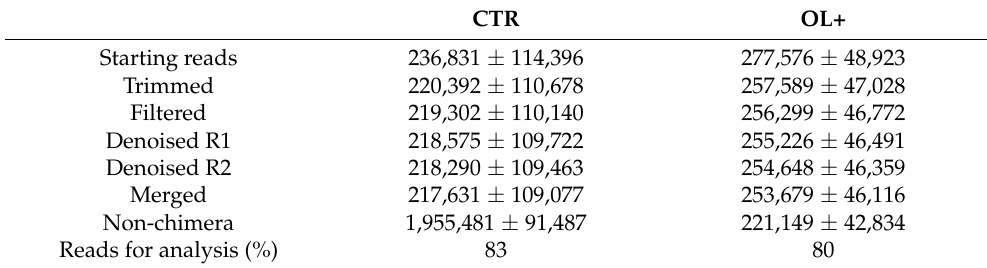
Table 2. Data acquisition for control group (CTR) and experimental group (OL+).